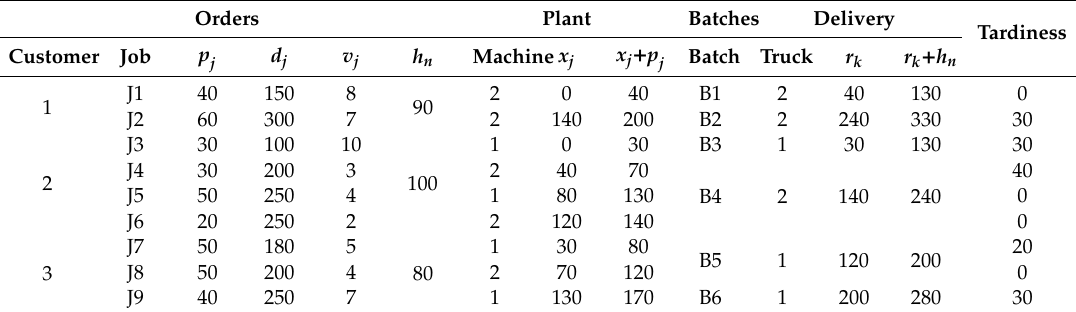
Figure 1. An example of schedules for the integrated scheduling problem. Table 1. Input data and the resulting tardiness of each job.